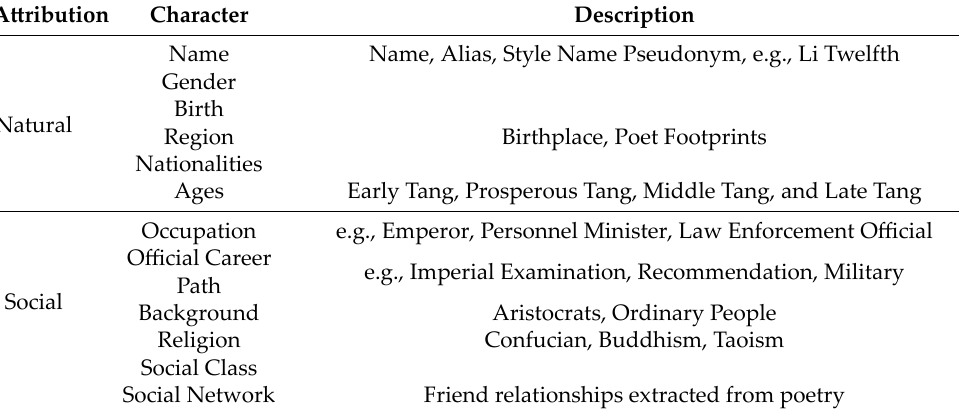
Table 1. Description of the authorship attribute